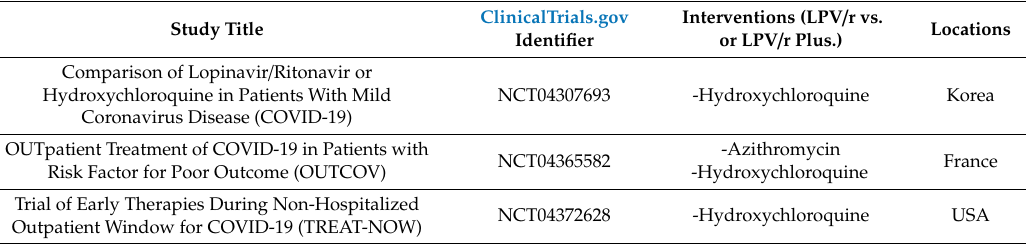
Table 2. Interventional trials investigating the e ffi cacy of lopinavir / ritonavir in COVID-19. ClinicalTrials.gov Interventions (LPV / r vs. Study Title Locations Identifier or LPV / r Plus.) Comparison of Lopinavir / Ritonavir or Hydroxychloroquine in Patients With Mild NCT04307693 -Hydroxychloroquine Korea Coronavirus Disease (COVID-19) OUTpatient Treatment of COVID-19 in Patients with Risk Factor for Poor Outcome (OUTCOV)